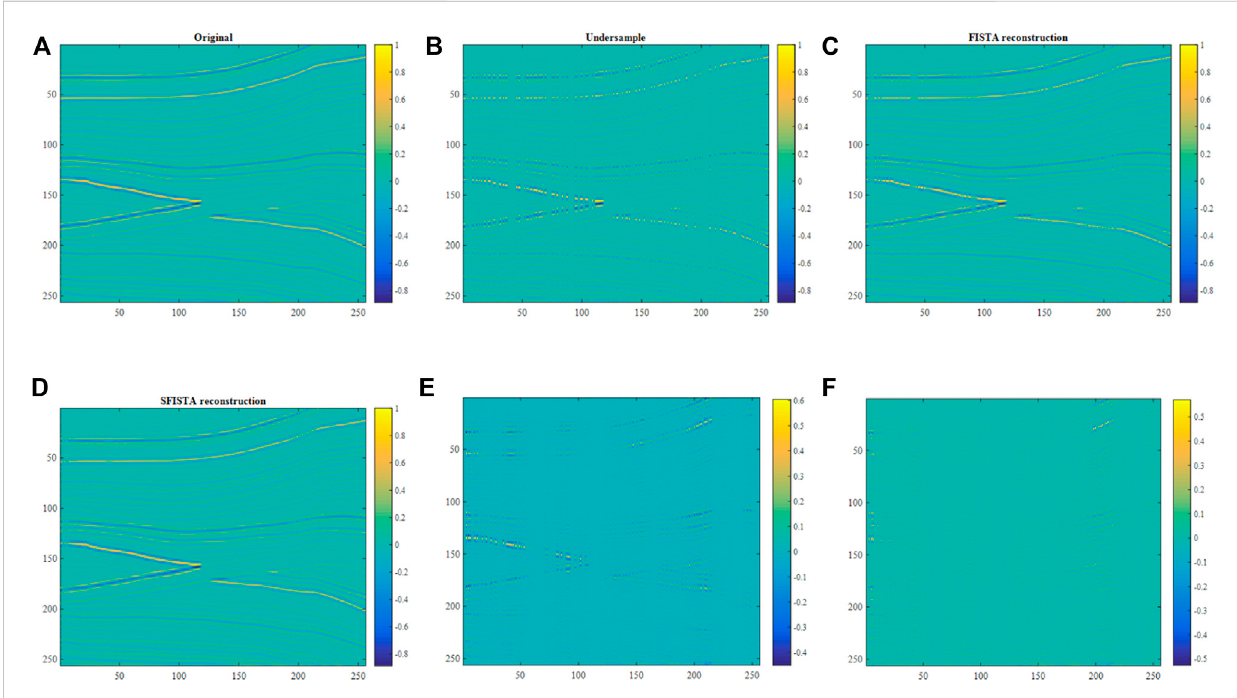
FIGURE 1 Reconstructionresultsofsyntheticdatainthecontourletdomain. (A) Originaldata; (B) 50%ofrandomlymissingdata; (C) interpolateddataobtained by the FISTA method; (D) interpolated data obtained by the SFISTA method; (E) reconstructed errors obtained by the FISTA method; (F) reconstructed errors obtained by the SFISTA method.